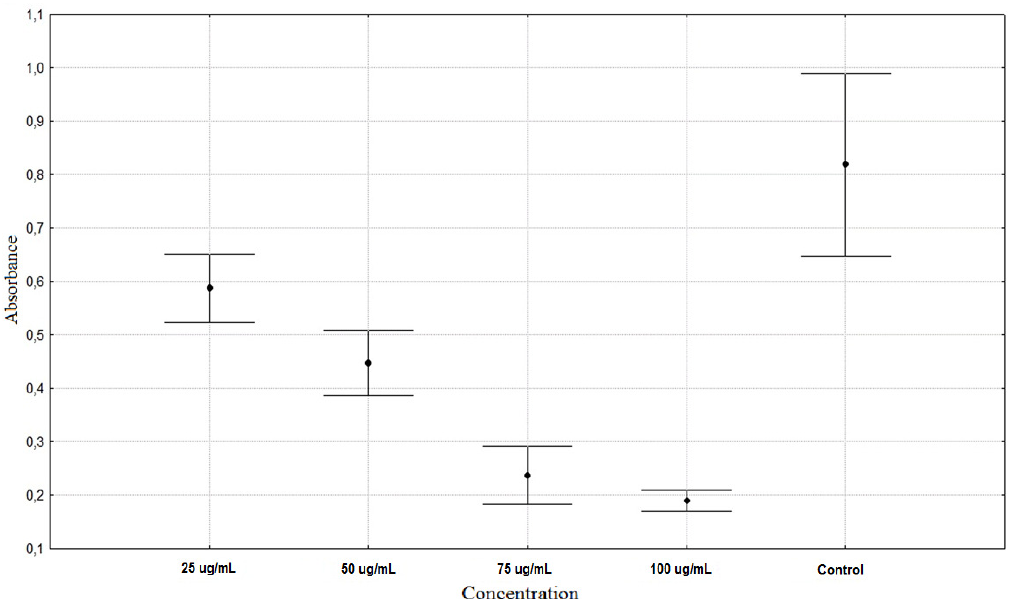
Figure 2. Antiproliferation activity of Rumex acetosa phenolic compounds on HaCaT cells (average ±